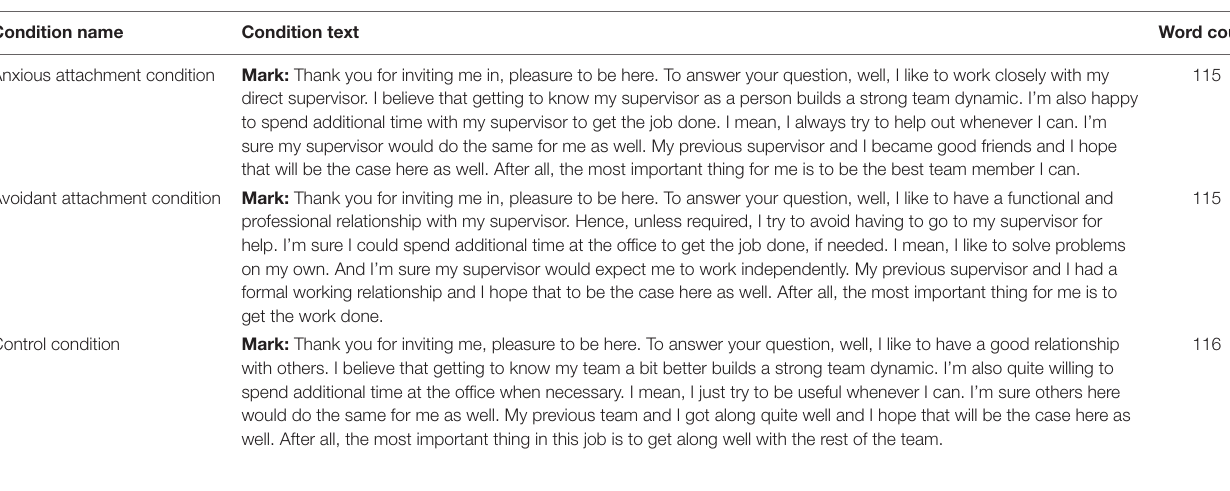
TABLE 1 | Description of vignette conditions (Study